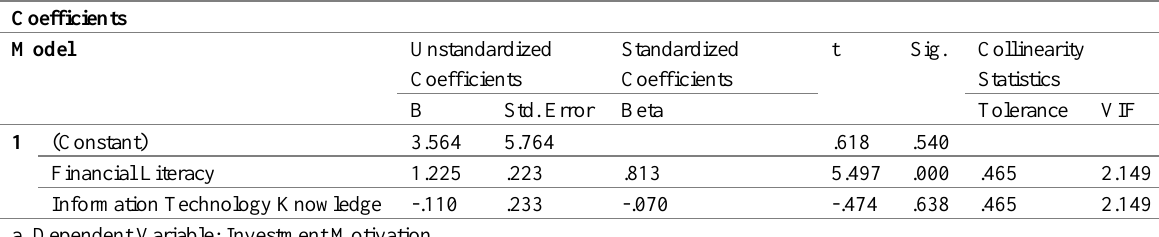
Table 2 . Multicollinearity Test